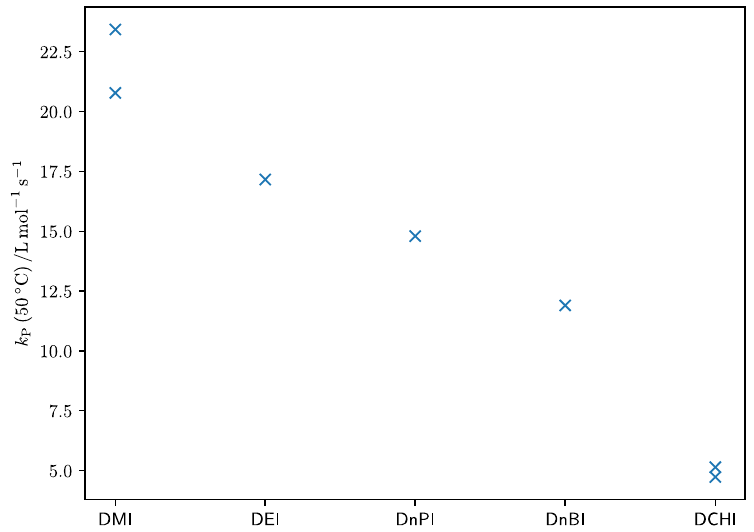
Figure 8. Values of k p at 50 °C for the family of itaconates using Arrhenius parameters from Table 6.